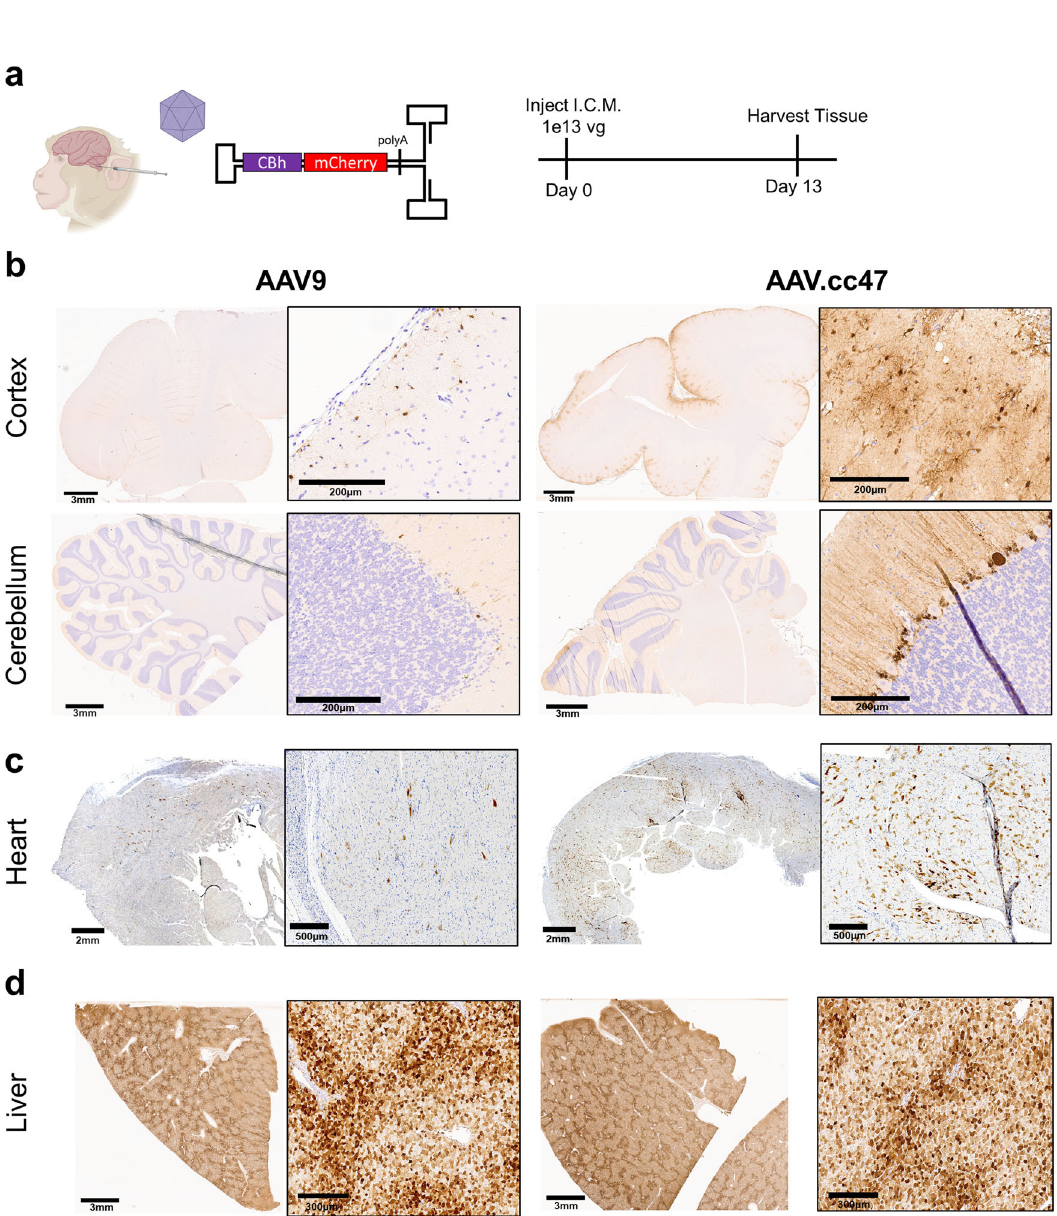
Fig. 5 | AAV.cc47 transduces non-human primate (NHP) brain and heart more effectively than AAV9 following intracisternal magna (ICM) infusion. a ICM infusion of 1e13 total vg of AAV9 or AAV.cc47 vectors in 2-year-old cynomolgus macaques ( n =2). Organs were harvested at 13 days post infusion. Vectors packa- ging self-complementary AAV genome with a truncated chicken beta-actin (CBh)